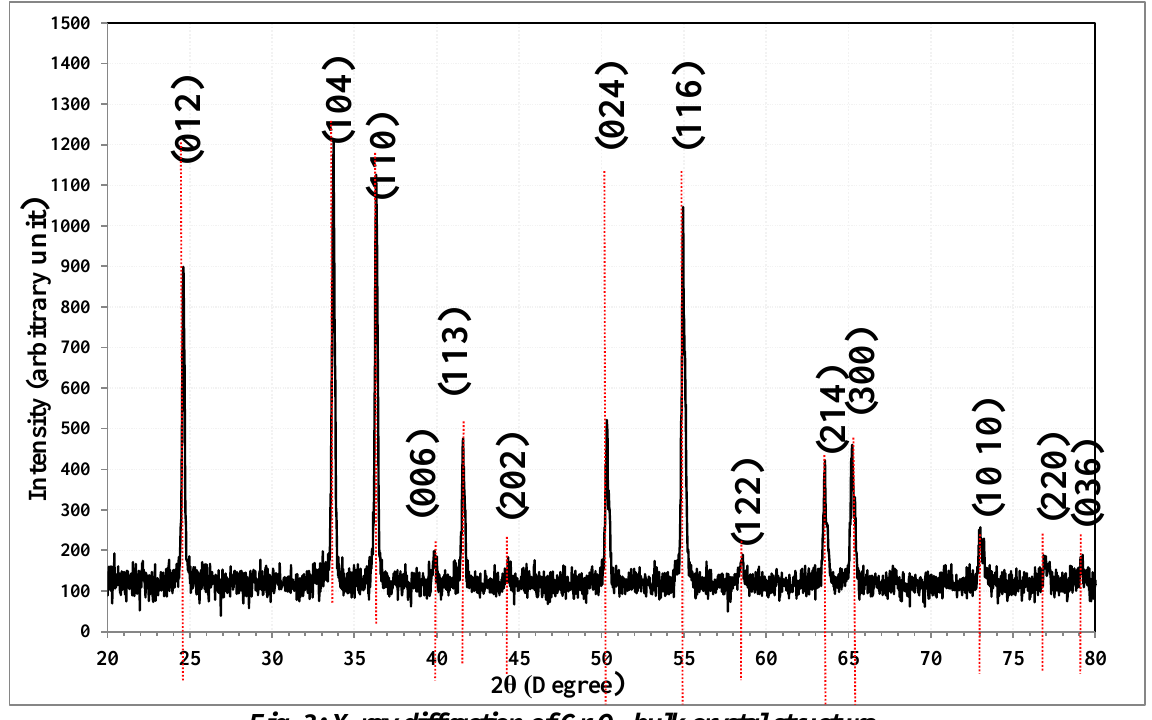
O bulk crystal structure. 2 3